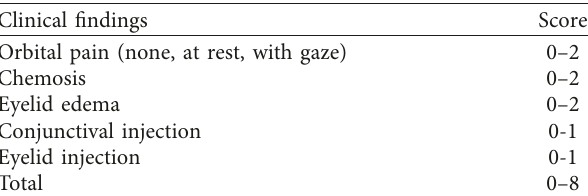
Table 1: VISA inflammatory score. Clinical